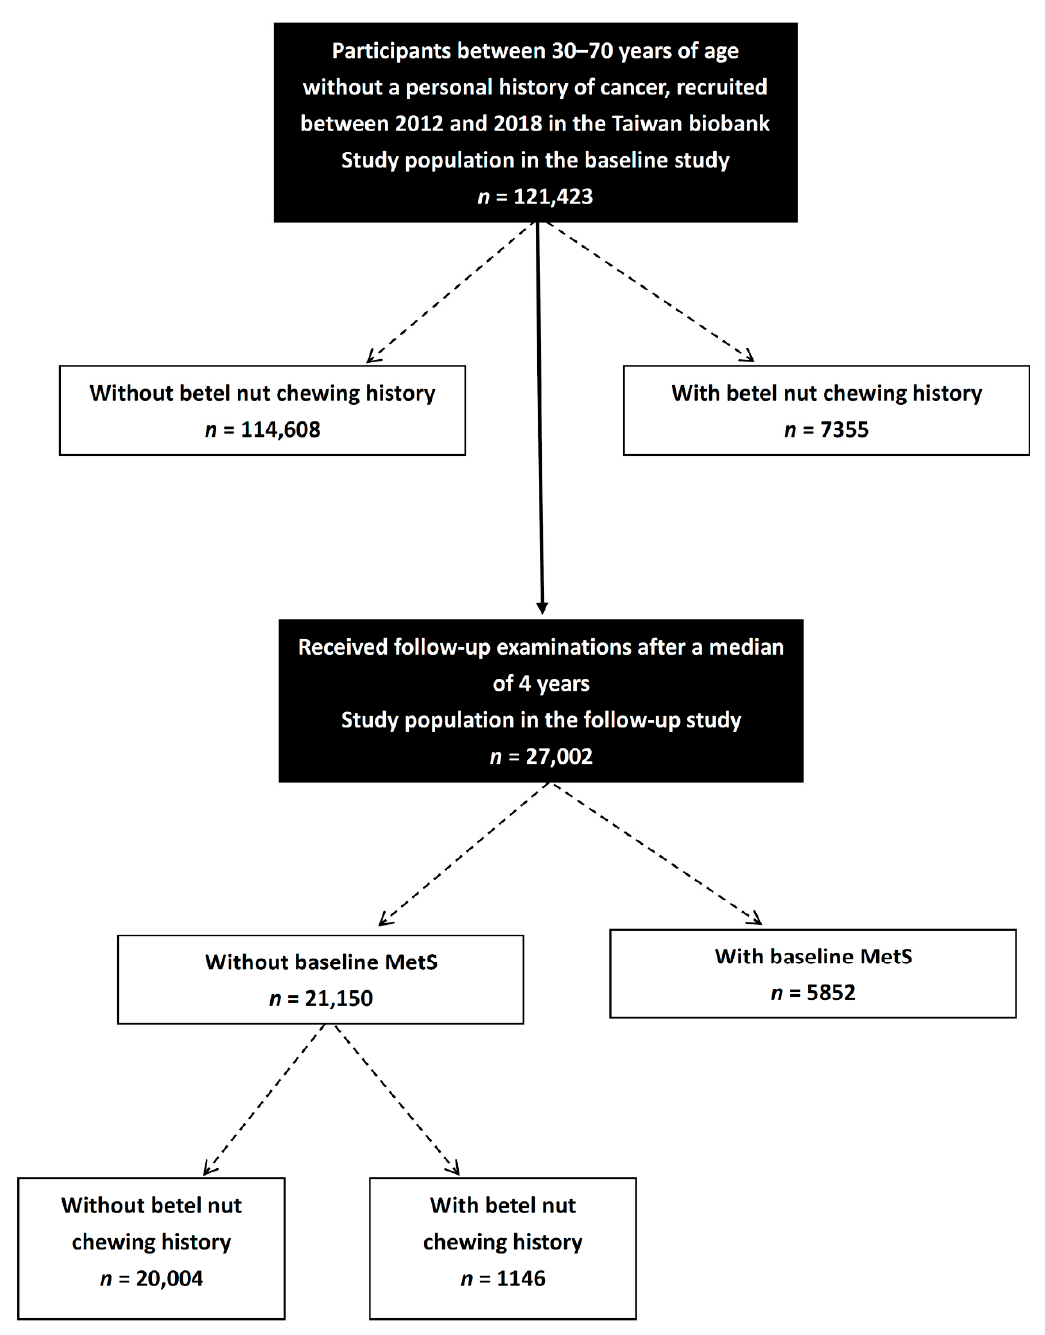
Figure 1. Flowchart of study